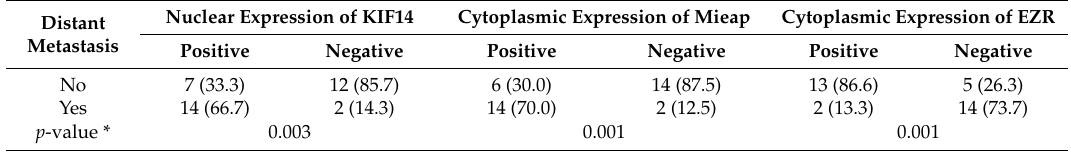
Table 2. Frequency of metastases in patients with expression of KIF14, Mieap, and EZR at the tips of torpedo-like structures in breast